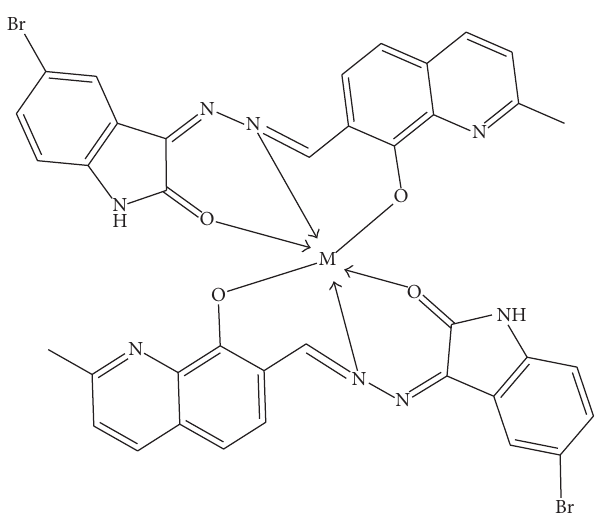
Figure 6: Proposed structure of Co(II), Ni(II), and Cu(II) metal complexes (octahedral).